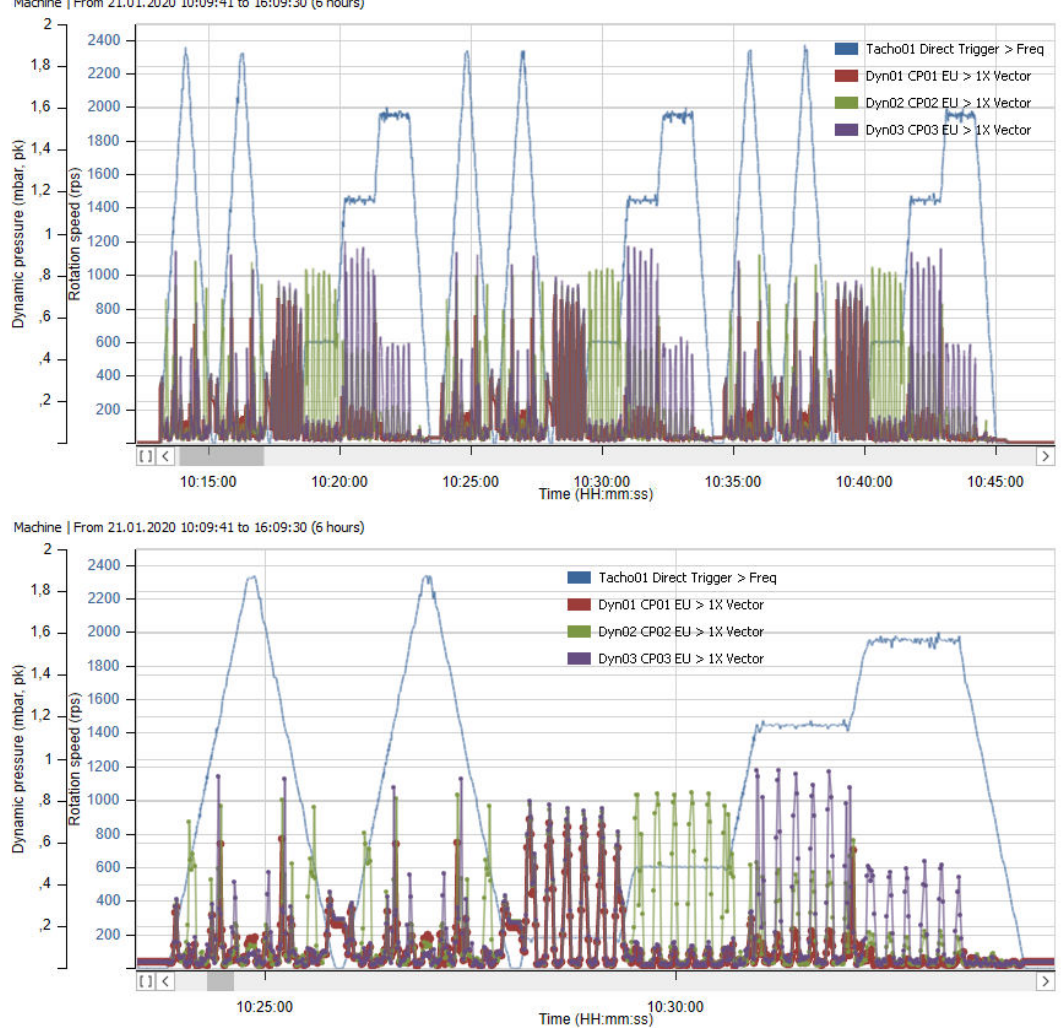
Figure 15. ”Kölner Dom” measurement performed on the emootion test facility [38] with non-reactive tests at standard conditions, nozzle 12 mm. ( Top ): Repetition 3 times of the characterisation sequence to verify the reproducibility. ( Bottom ): Focus on one